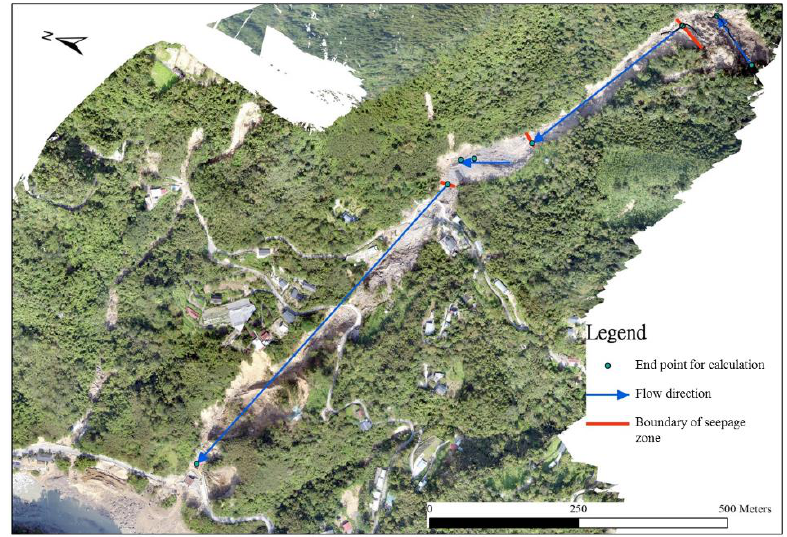
Figure 10. Seepage zones and directions.